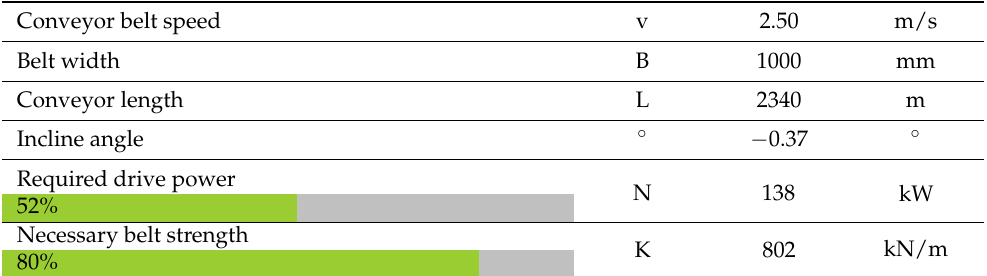
Table 3. Basic parameters and results of conveyor verification calculations.